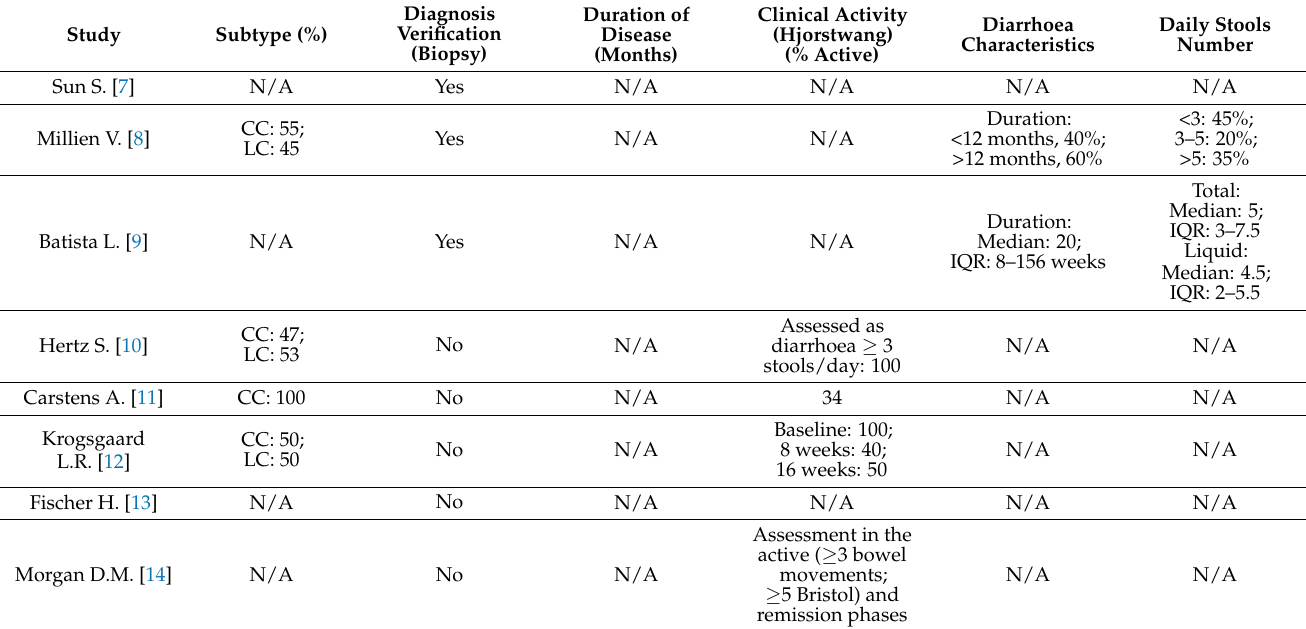
Table 3. Description of microscopic